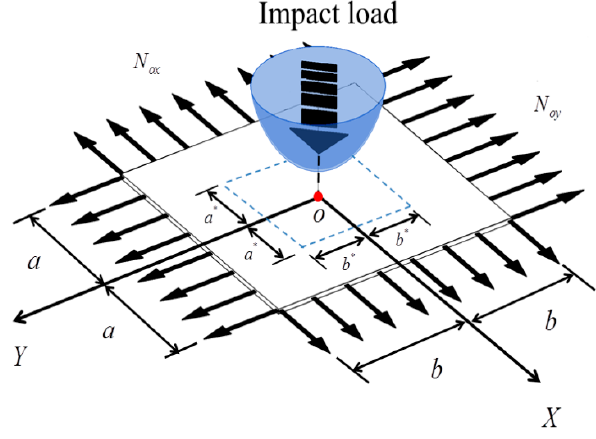
Figure 1. The model of orthotropic pre-stressed rectangular membrane under impact load.